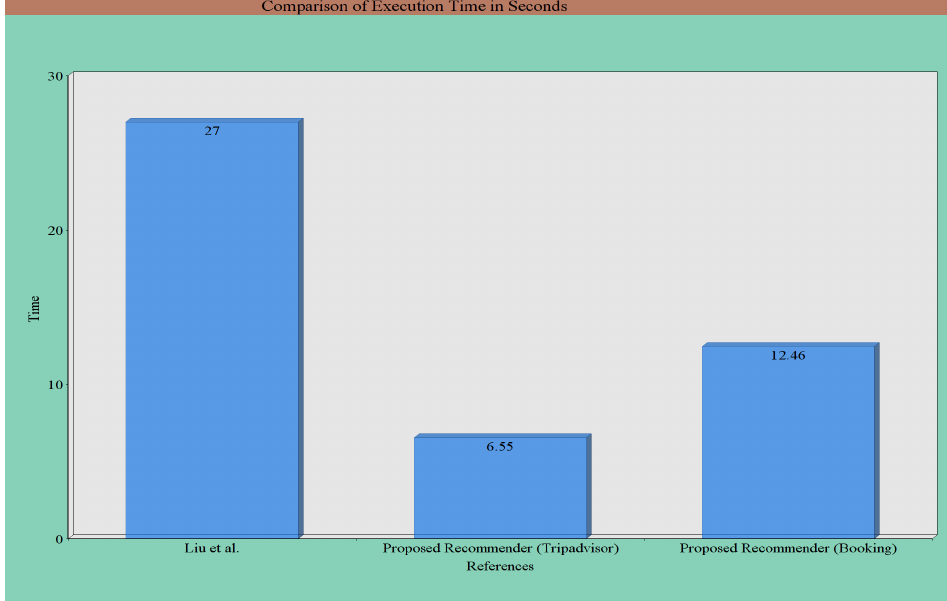
Figure 10. Runtime comparisons of our proposed method with